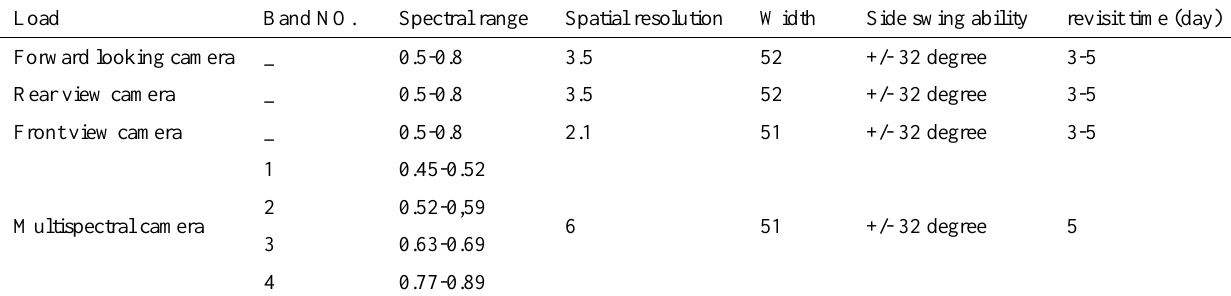
Table 4 . Technical index of ZY3 satellite payload